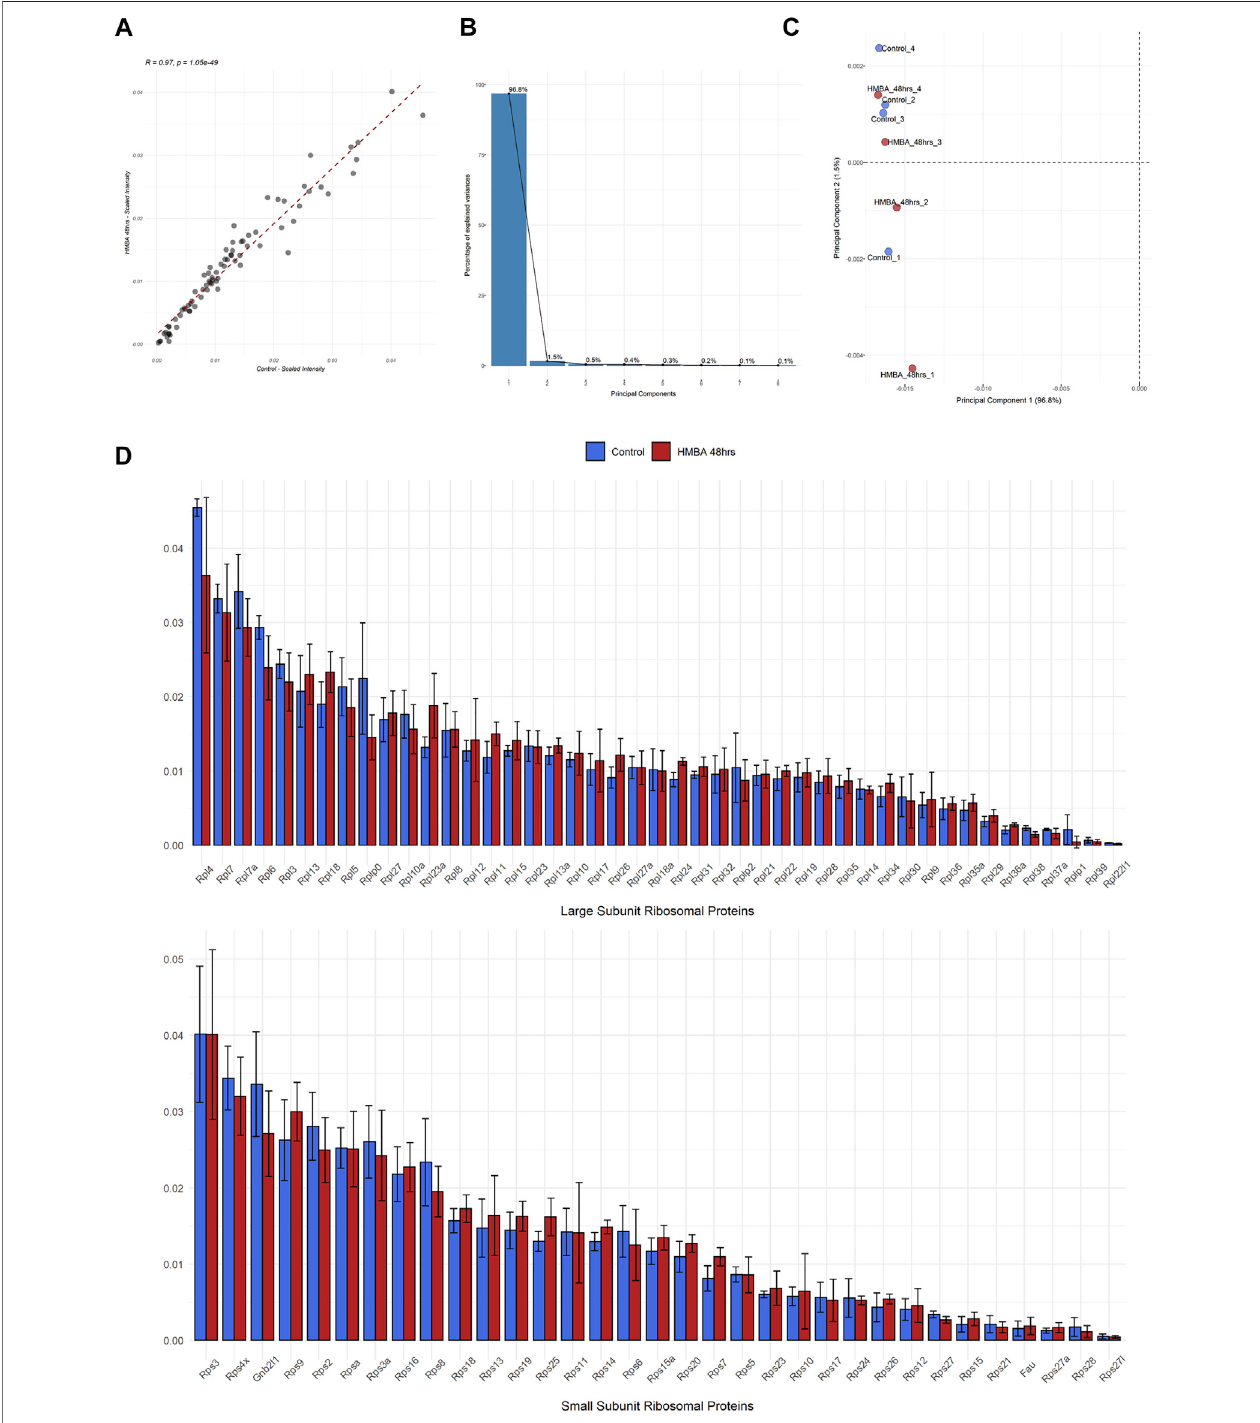
FIGURE 3 | Proteomic analysis of the RP component of the ribosome during MEL cell differentiation. (A) Scatterplot of the average scaled intensity values per RP, depictingastrongpositivecorrelation (Pearsoncorrelationcoef fi cient=0.97) inRPstoichiometrybetweenuntreated (Control)anddifferentiated (HMBA48 h)MELcells. (B) Screeplotdepictingthepercentageofvarianceexplainedbyeachprincipalcomponent(PC)fortheanalysisshowninC. (C) ScatterplotofPrincipalComponents(1st and2nd)ofallindependentbiologicalreplicationsoftheribo-proteomicsexperiment.PrincipalComponentAnalysis(PCA)wasperformedusingRPscaledintensity values. (D) BarplotsdepictingtheaveragescaledintensityofeachRPinControlandHMBA48 h(upperpanellargesubunitRPs,bottompanelsmallsubunitRPs).Error bars correspond to the standard deviation of scaled intensity values per RP and differentiation stage.